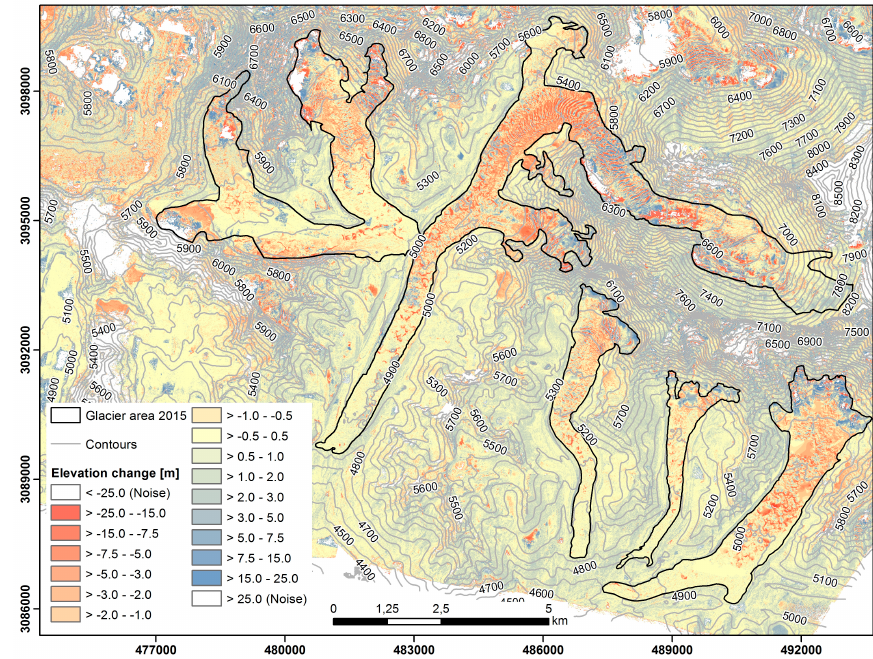
Figure 15. Summer surface elevation change of Khumbu, Lhotse Nup, Nuptse, and Lhotse glaciers. UTM 45 N.